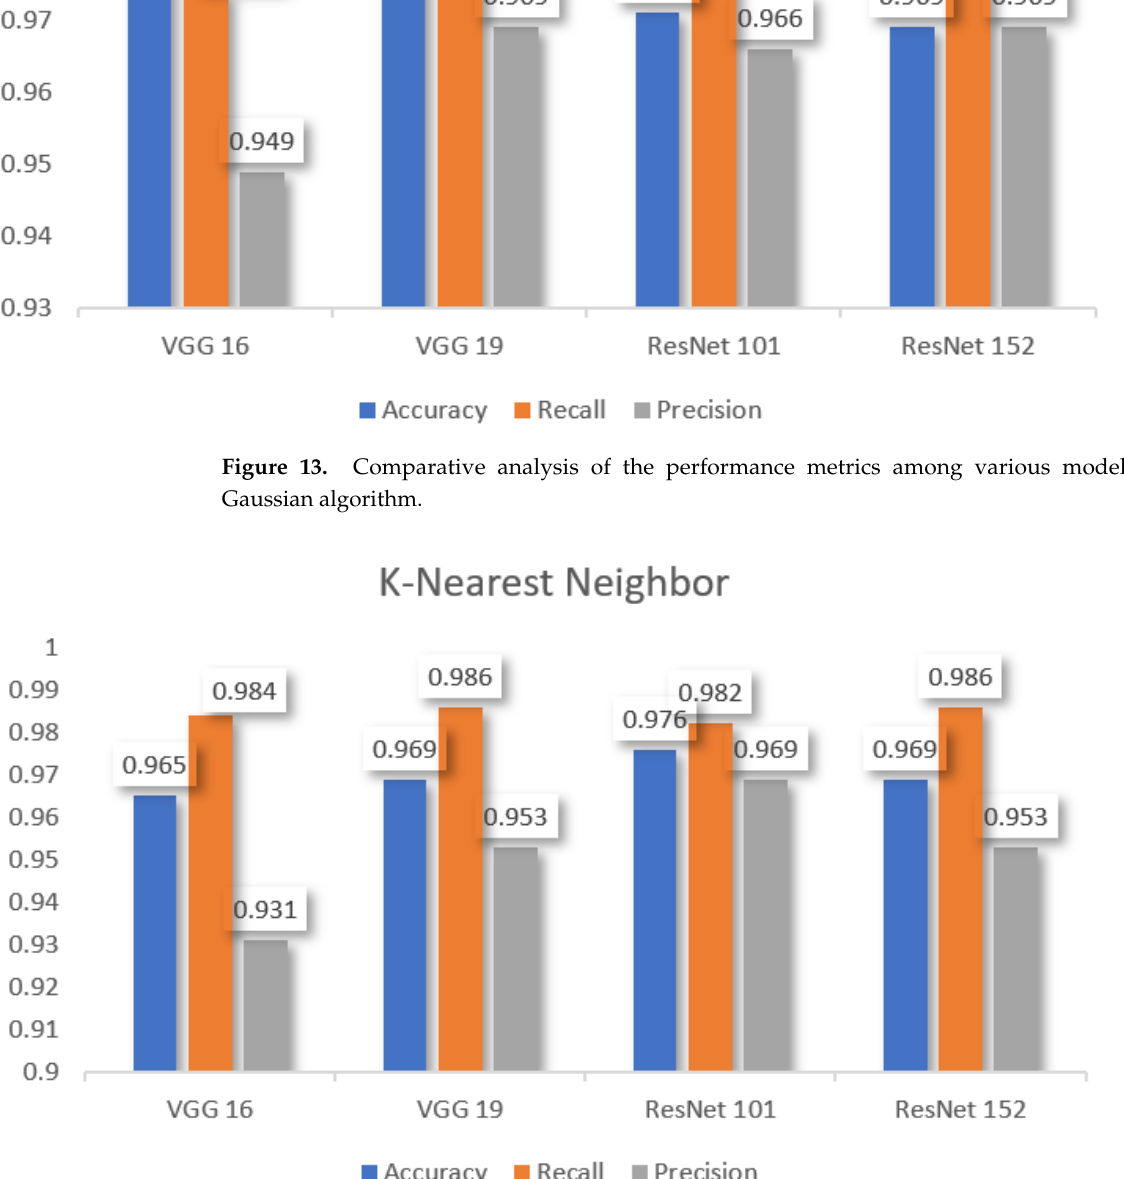
Figure 15. Comparative analysis of the performance metrics among various models using decision tree.